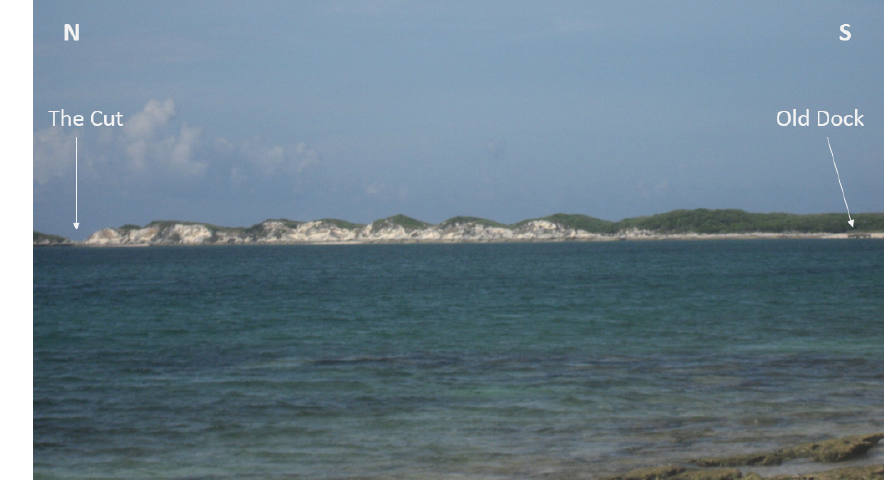
Figure 2. The Grahams Harbour section from Old Dock (start transect) to the Cut (end transect). Photo: Andrea Fischel,